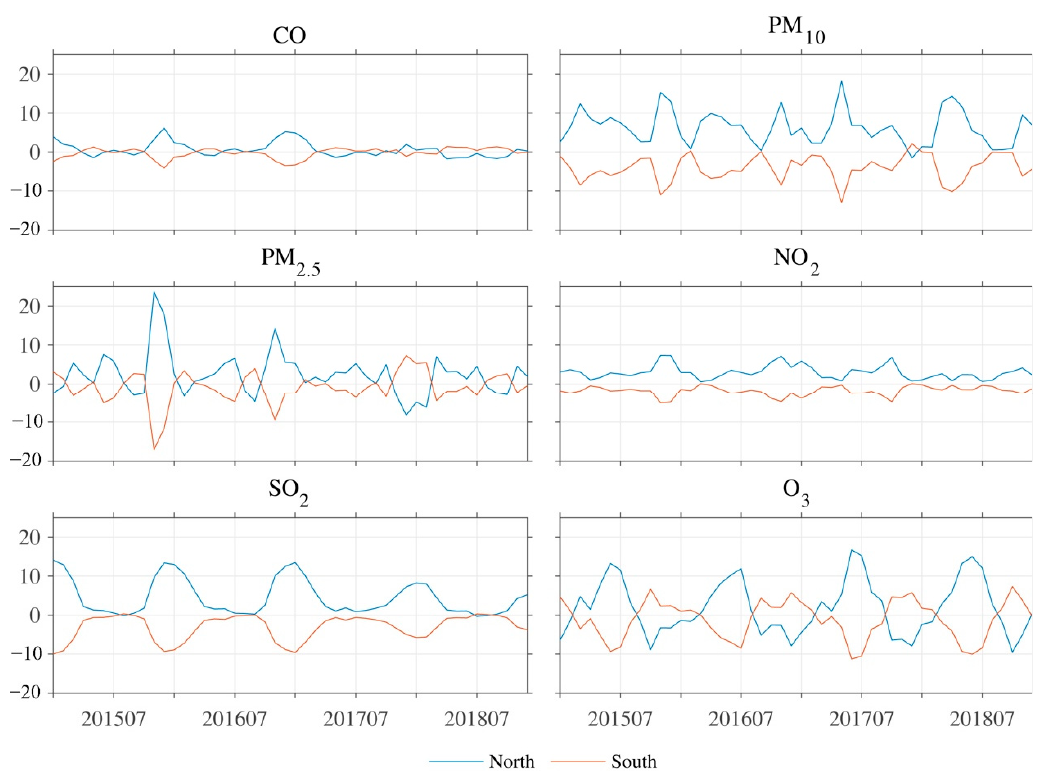
Figure 5. Monthly mean individual AQI anomalies of CO, PM 10 , PM 2.5 , NO 2 , SO 2 , and O 3 in northern (blue lines) and southern (orange lines) Eastern China from 2015–2018.